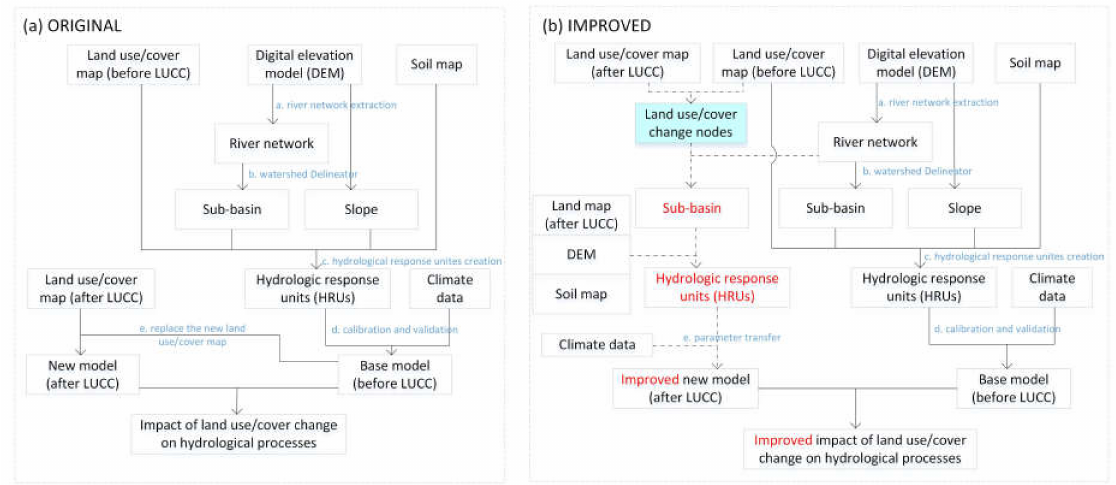
Figure 3. Schematics of: ( a ) original analysis approach of the LUCCIHP; and ( b ) improved sub-basin segmentation approach of the